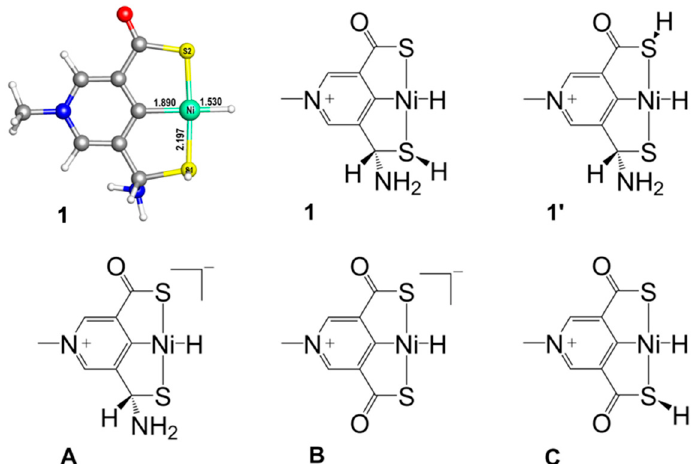
Figure 1. Proposed Ni pincer complex in this work ( 1 ) and its isomer with the proton on the other sulfur atom ( 1’ ), deprotonated structure of 1 ( A ), Ni hydride complex with Hu and co-workers’ symmetric SCS pincer ligand ( B ), and B with a proton on sulfur ( C ).